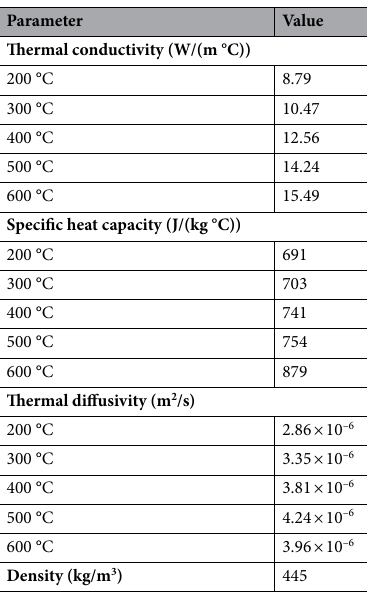
Table 1. Thermal properties of the titanium alloy at different